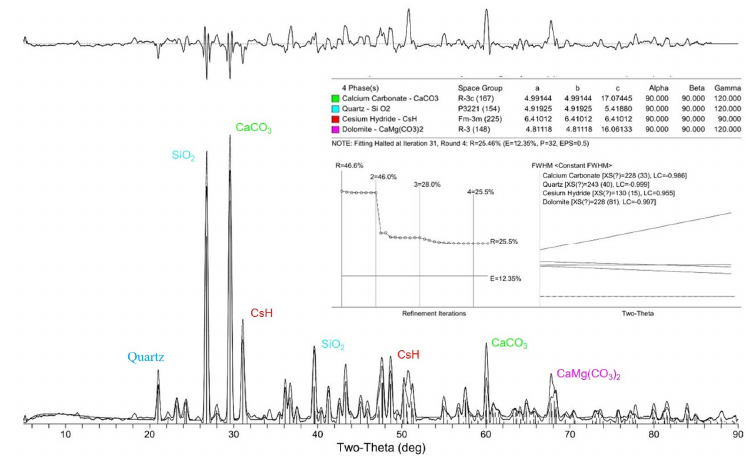
Figure 13. Physical phase analysis of RCA group specimens.